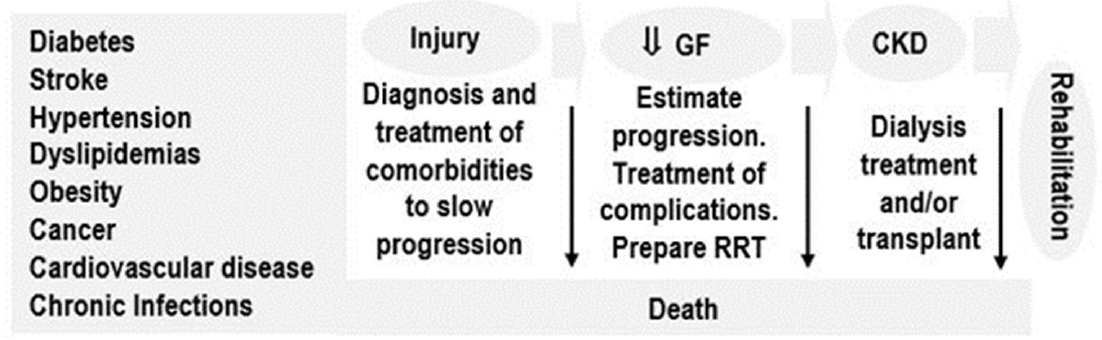
Figure 1. The continuum of renal disease focusing on individual risk factors. Produced by the authors.